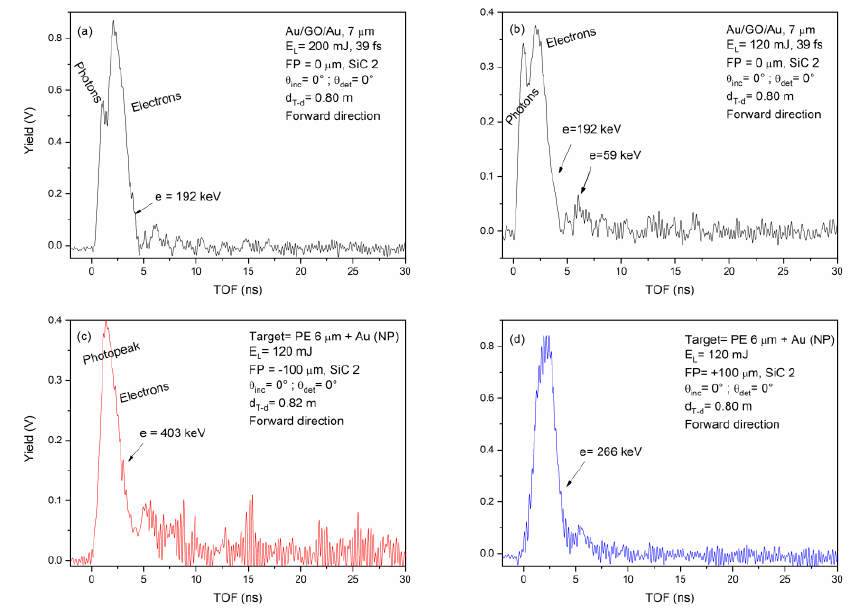
Figure 8. SiC-TOF spectra in the forward direction and 0° detection angle by irradiating Au/GO/Au foil at 120 mJ ( a ) and 200 mJ ( b ) with FP = 0 μm and irradiating Au/GO/Au foil at 120 mJ with FP = −100 μm ( c ) and FP = +100 μm ( d ).